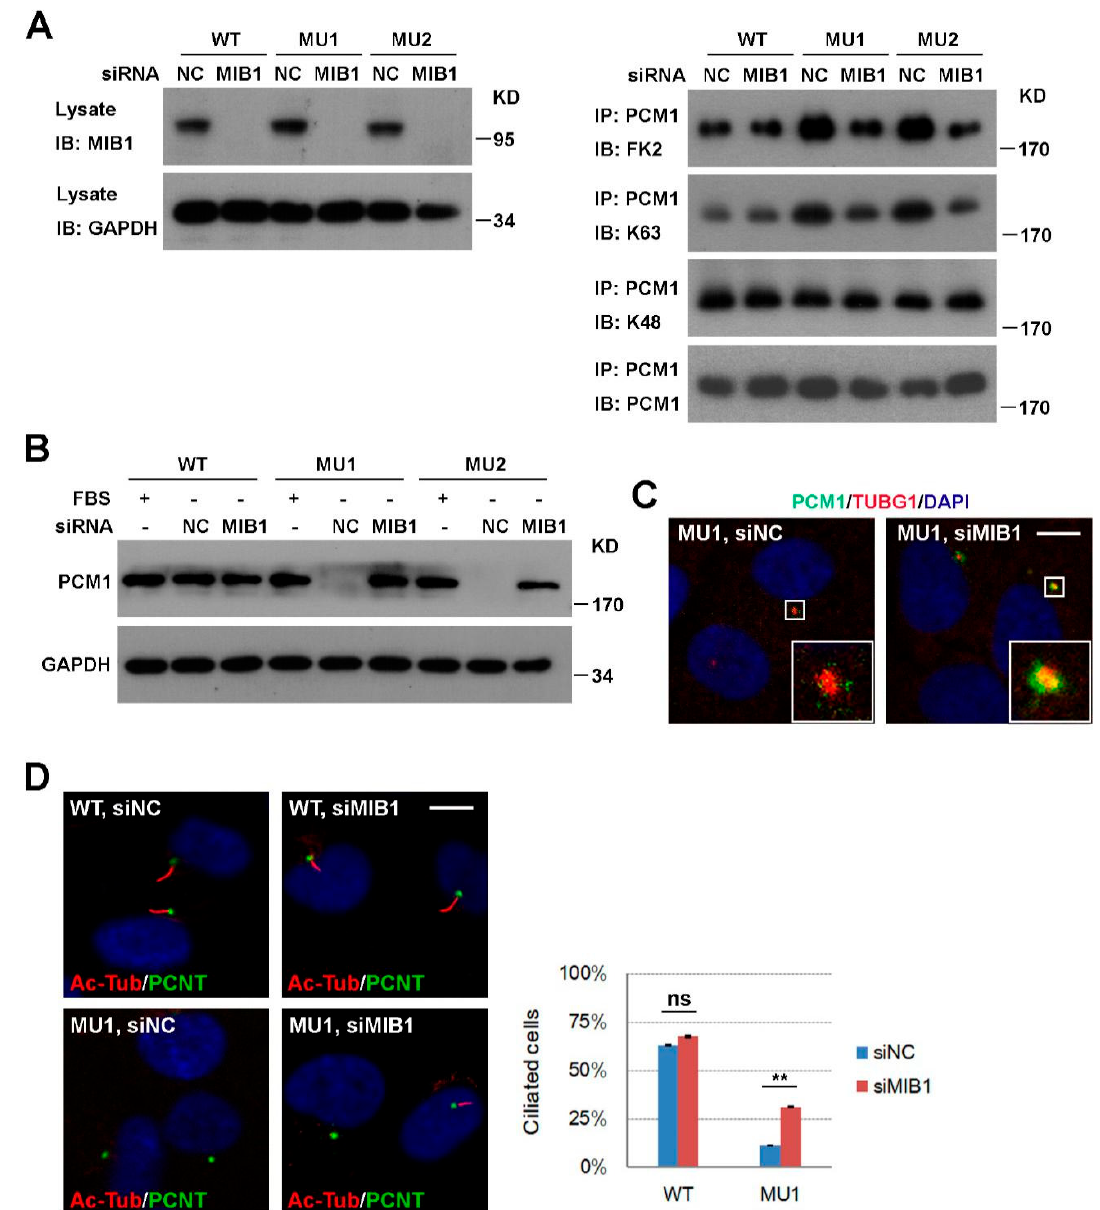
Figure 5. Knockdown of mindbomb 1 (MIB1) rescues ciliogenesis defects in SNX17 mutant cells. ( A ) Analysis of PCM1 ubiquitination after MIB1 knockdown. Cells were transfected with the indicated siRNAs for 48 h, serum-starved for 24 h, and then analyzed as described in Figure 4C. siMIB1 treatment rescued PCM1 protein levels in SNX17 mutant cells at 48 h after serum starvation as determined by ( B ) western blot or ( C ) immunofluorescence staining. ( D ) siMIB1 treatment restored serum-starvation-induced ciliogenesis in SNX17 mutant cells. Right panel shows the statistical results. Data represent mean ± SD from three independent biological repeats (ns, non-significant; ** p < 0.01 in one-way ANOVA with Tukey’s multiple comparison test). Scale bar, 10 µm.